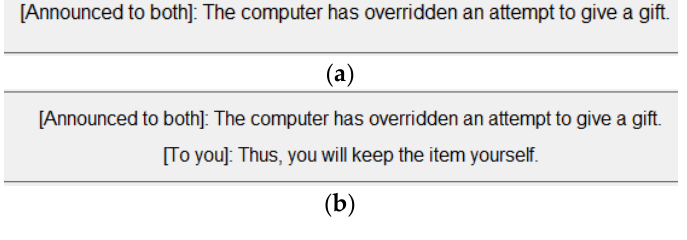
Figure 4. Overturned gift messages. ( a ) Message to dictator; ( b ) Message to gift‐giver.